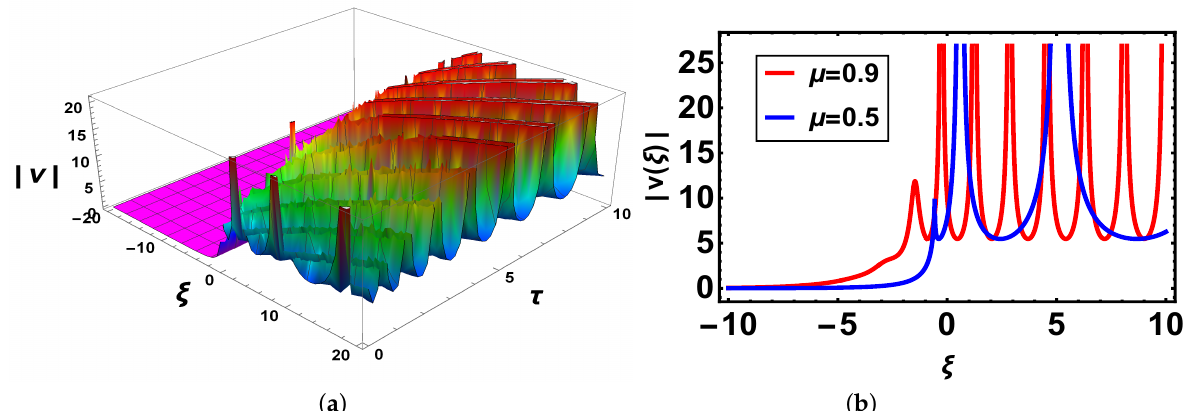
Figure 5. ( a ) 3D and ( b ) 2D plots with same parameter values as above µ = 0.5 of v 25 ( ξ , τ ) with the